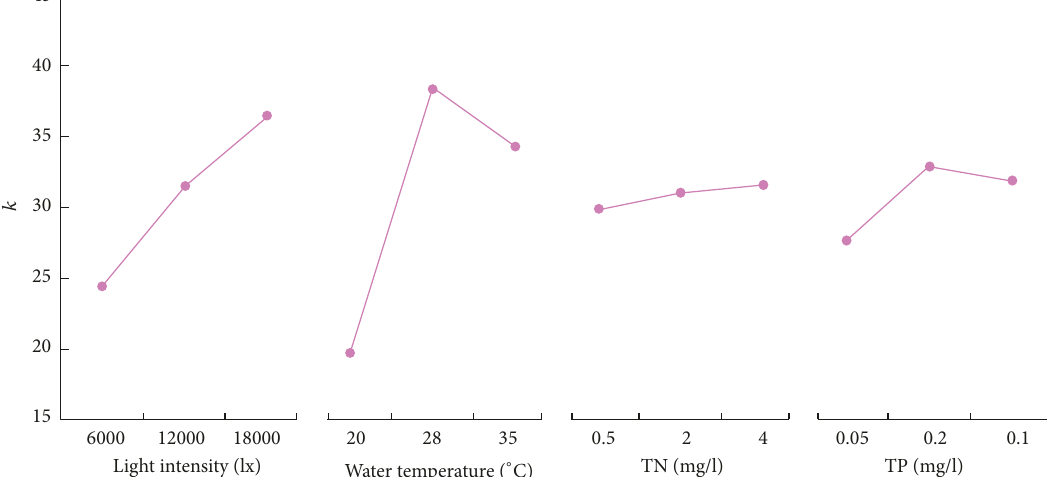
Figure 1: L 9 (3 4 ) orthogonal experiment: intuitive analysis diagram of algae with largest stock on hand.